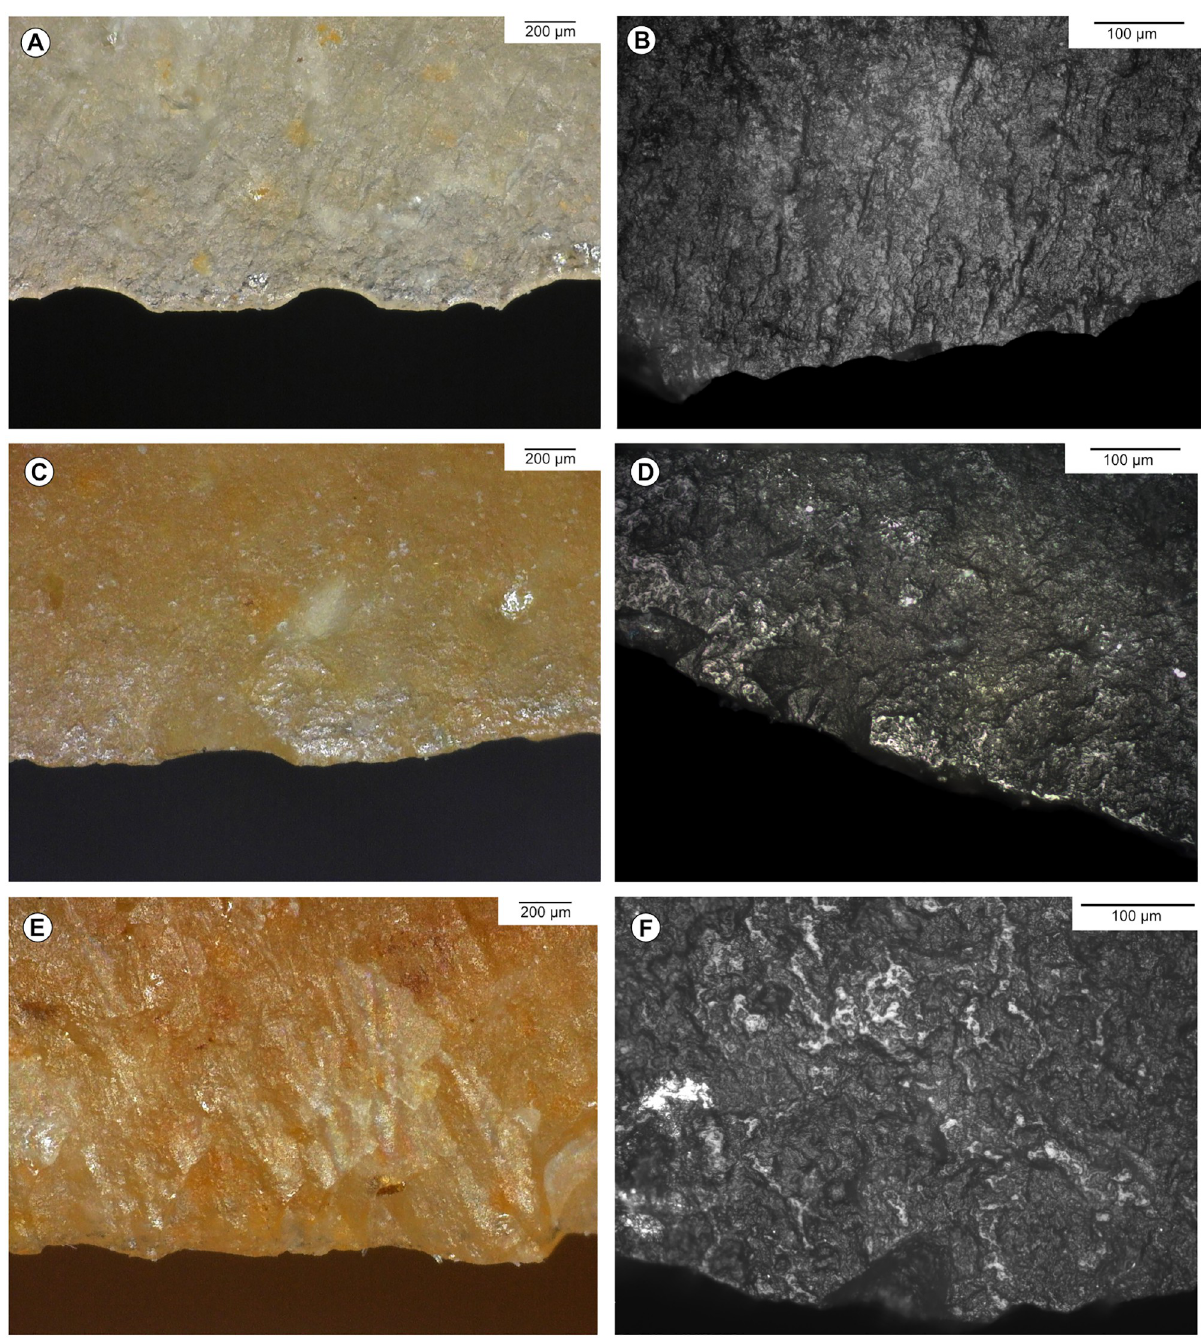
Fig 5. Experimental vegetal working traces on flint. A, B-Cutting nettle, 10 mn. C, D-Sawing fresh chestnut tree, 10 mn. E, F-Sawing fresh lime tree, 10 mn. https://doi.org/10.1371/journal.pone.0274819.g005 retouched bladelets are on average 7.1 mm wide (standard deviation 1.5 mm) and 2.8 mm thick (standard deviation 0.9 mm) at the first site, and 5.1 mm wide (standard deviation 1.2 mm) and 2.3 mm thick (standard deviation 0.7 mm) at the second site. Blades are robust, being on average 25.7 mm wide (standard deviation 7.6 mm) and 8.4 mm thick (standard